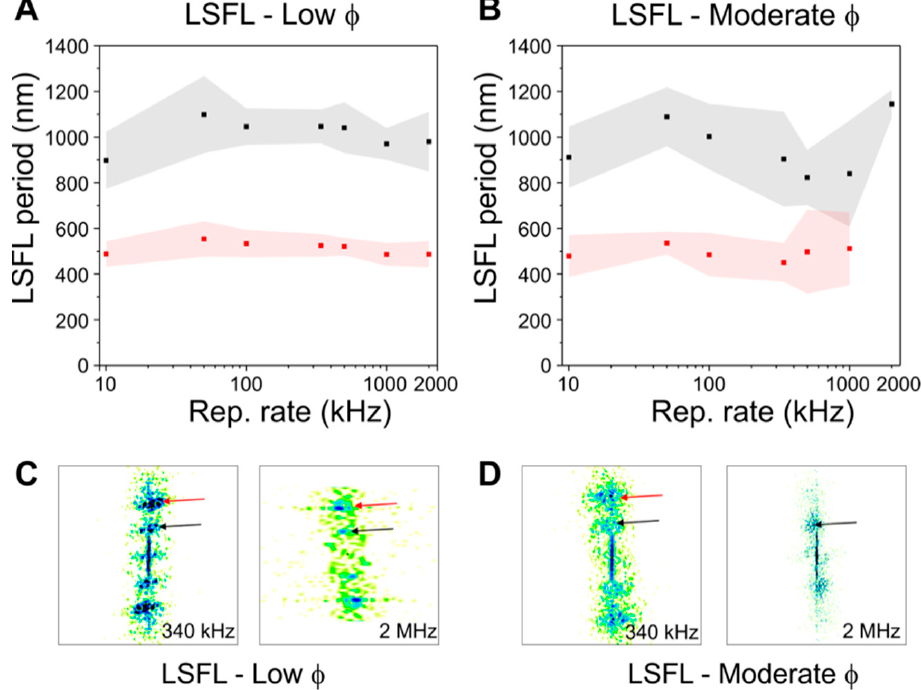
Figure 6. LIPSS periodicity at ( A ) low and ( B ) moderate laser fluences ( ϕ ) for different repetition rates, ranging from 10 kHz to 2 MHz. The LSFL structures contain two sets of periodicities, one plotted as black squares (and gray error bars as shadowed areas) for periodicities close to the laser wavelength (~1 µm) and a second one plotted as red squares (and red error bar regimes as shadowed areas) for smaller periods (~500 nm). The central period values and error bars were calculated from the FFT maps following the procedure described in [24] for each SEM micrograph shown in Figure 5. A selection of FFT maps is included in ( C ) for LSFL at low fluences at 340 kHz and 2 MHz, and ( D ) for moderate fluences for the same repetition rates, to visualize the coexistence of two clouds of points, indicative of the presence of two different periods, except for LSFL—moderate fluence at 2 MHz.